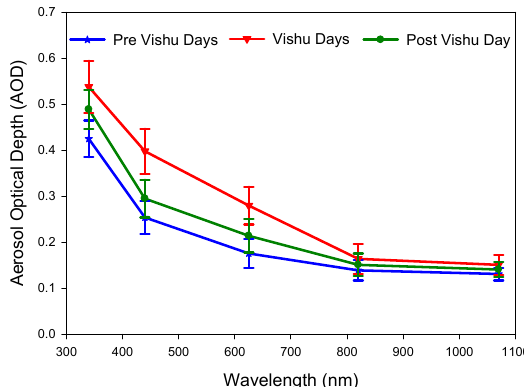
Figure 2. Variation of the mean aerosol optical depth (AOD) (over 2015–2018) on pre-, post-, and Vishu day for different wavelengths. The vertical bar in the graph represents one sigma standard deviation. Mean values of AOD for 340 nm, 440 nm, 625 nm, 820 nm, and 1070 nm on Vishu day are 0.538 ± 0.570, 0.398 ± 0.490, 0.280 ± 0.410, 0.164 ± 0.321, and 0.151 ± 0.212, respectively.